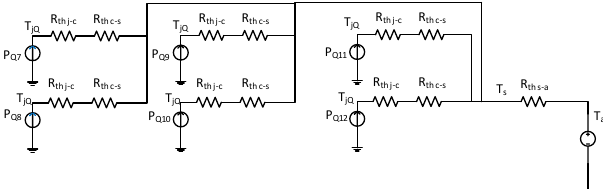
Figure 5. Equivalent thermal model for dissipation of the heat generated by the inverter switches.